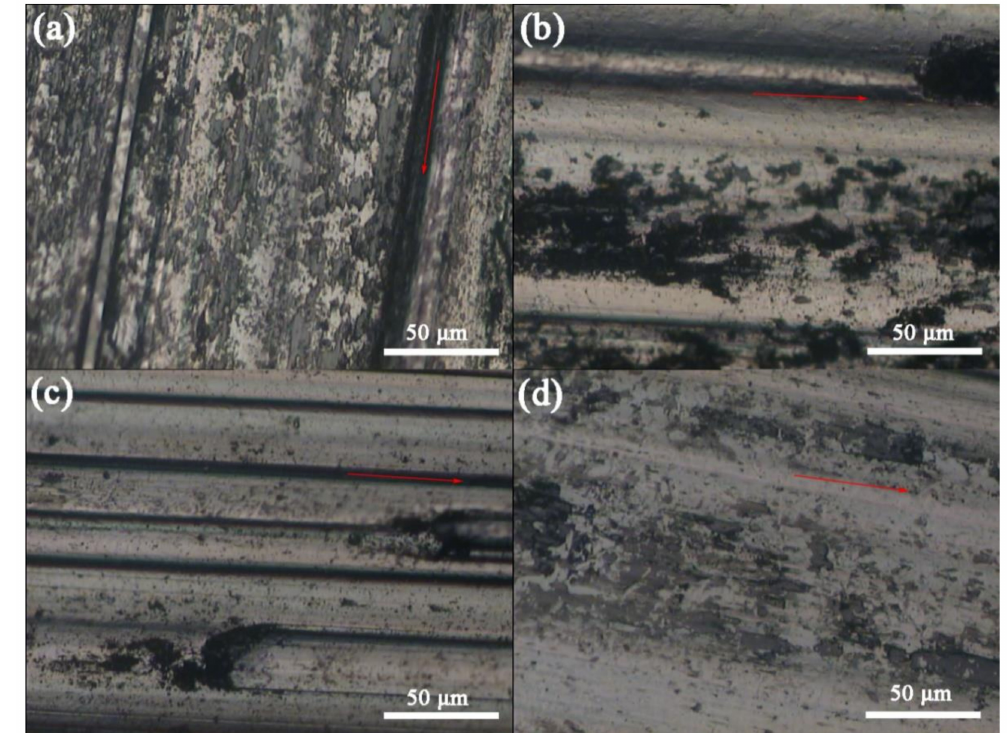
Figure 6. The morphologies of worn coatings: ( a ) Fe-5, ( b ) Fe-10, ( c ) Fe-15 and ( d )